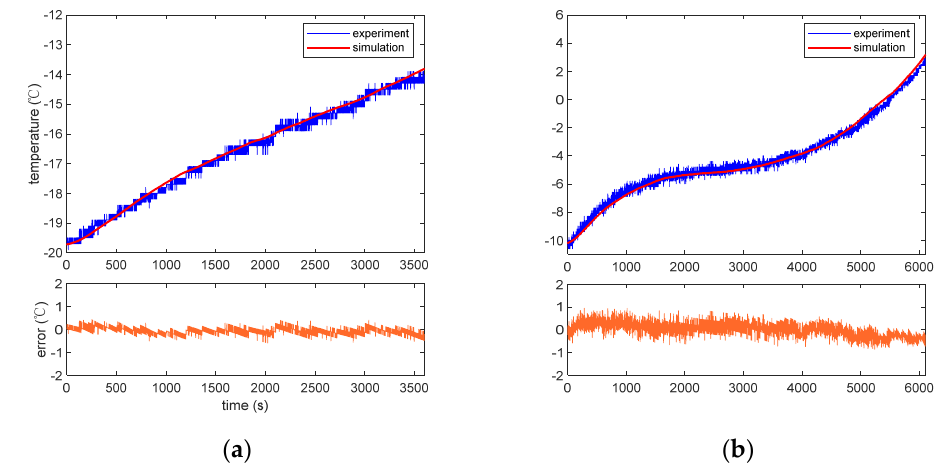
Figure 12. External heating tests at constant discharging current and constant heating power. ( a ) Initial cell temperature of − 30 °C, initial SOE of 30%, cell discharging current of 5 A and a heating power on each cell of 1 W; ( b ) initial cell temperature of − 10 °C, initial SOE of 100%, cell discharging current of 10 A and a heating power on each cell of 2 W.